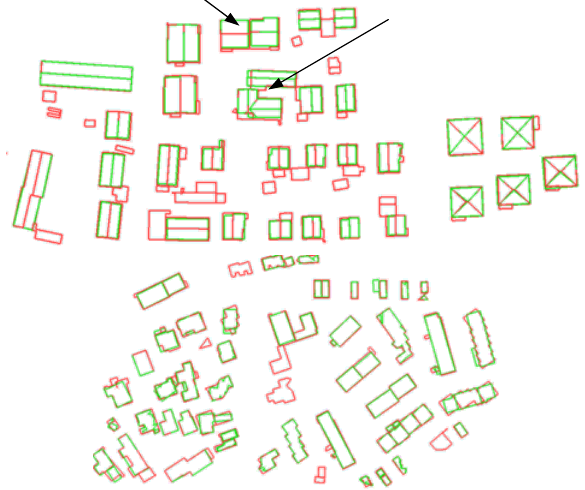
Figure 8: Visual appearance of roof models: red - 3D roof models reconstructed from high density data, green – with low density data (for the clarity, aerial view is chosen)